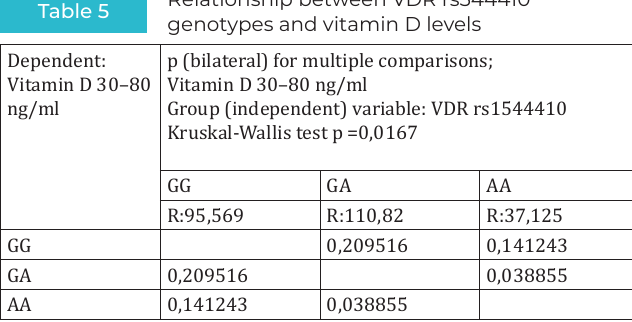
Relationship between VDR rs544410 genotypes and vitamin D